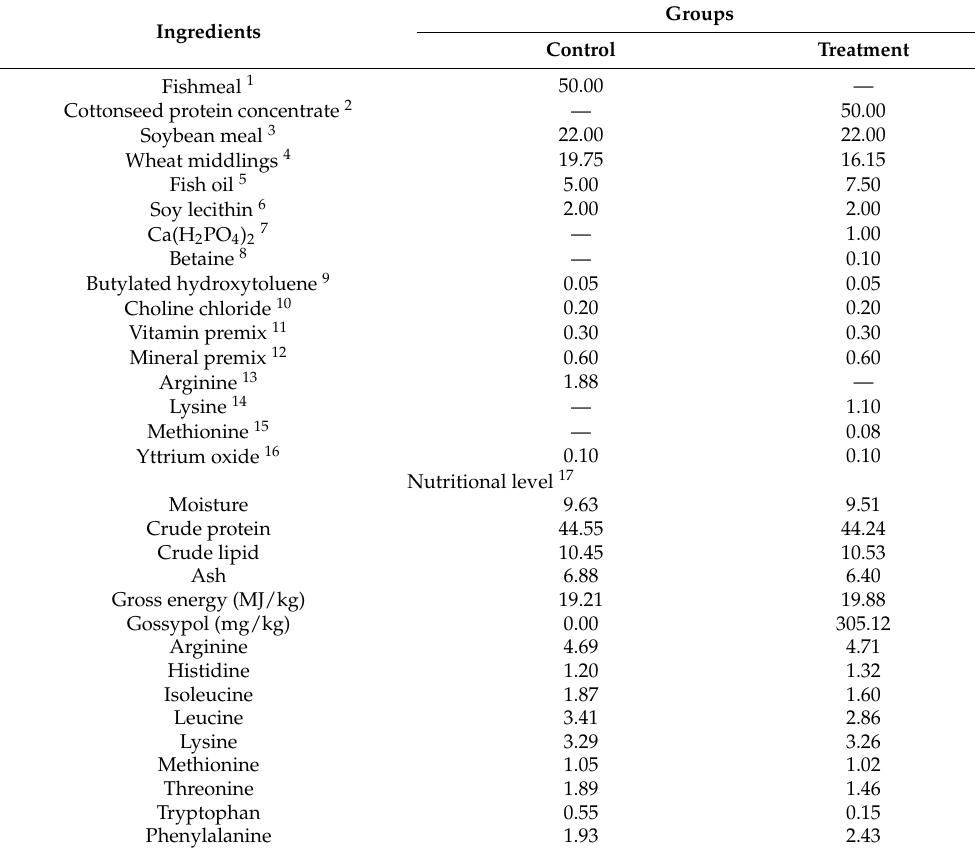
Table 1. Nutrients and ingredients used to prepare the diets (air-dry basis, %). Ingredients